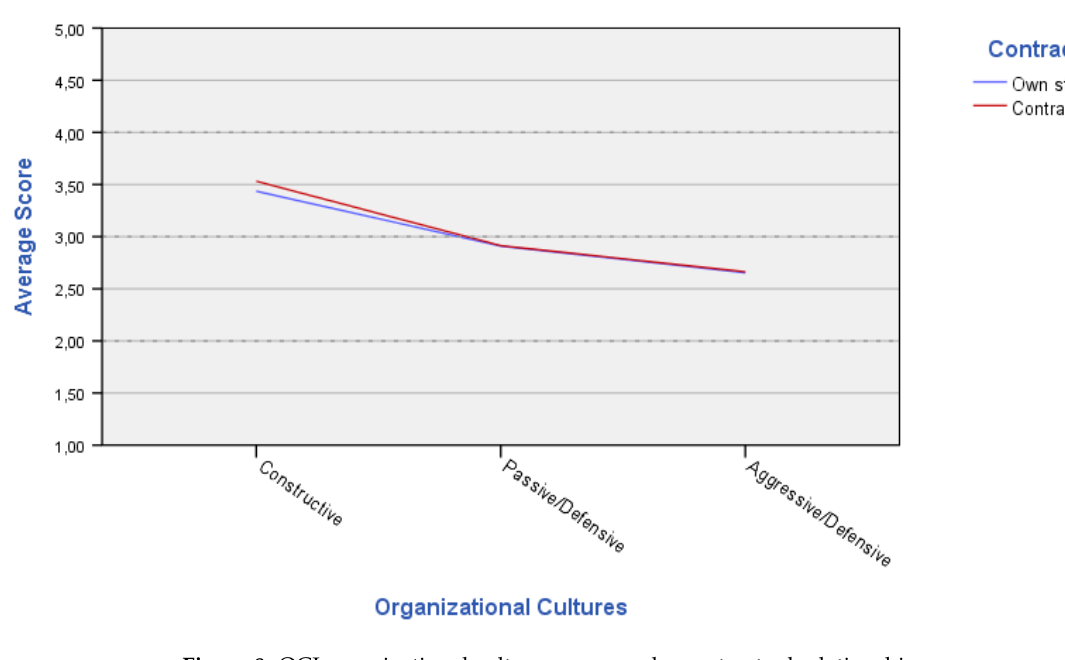
Figure 8. OCI organizational cultures averages by contractual relationship.